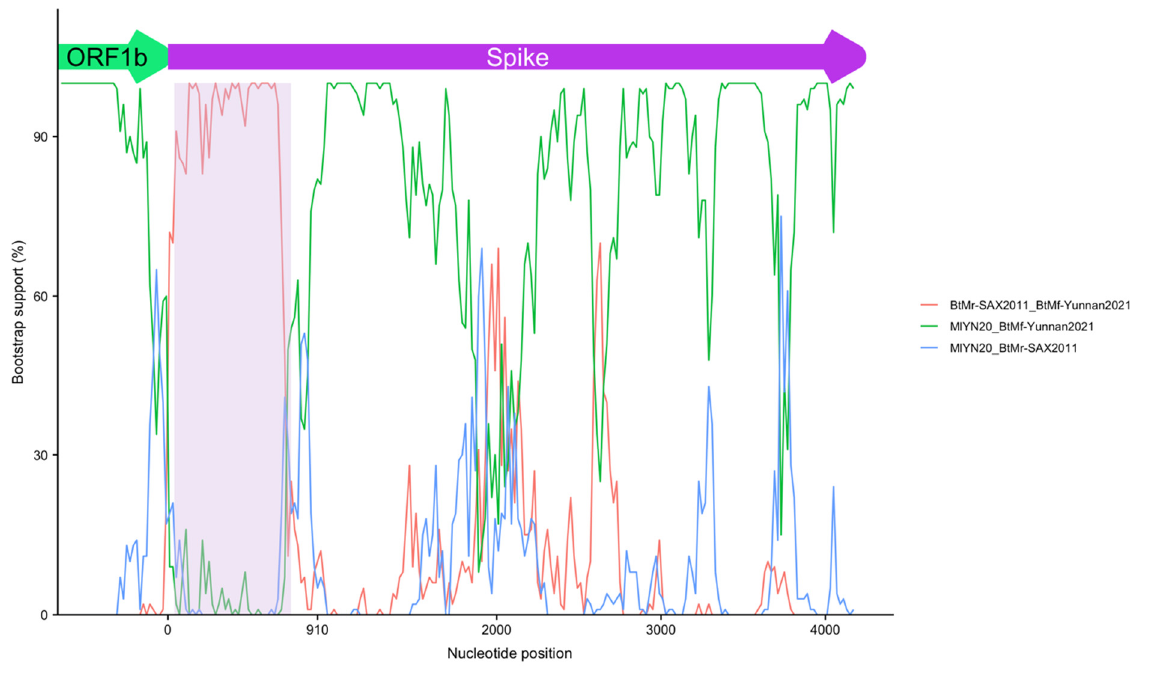
Figure 8. Spike recombination. Bootstrap support for recombination in subunit 1 of the spike protein of BtMf-Yunnan2020. The recombination involves the first 750 nucleotides of the spike (shaded area). The BtMr-SAX2011 spike was identified as the minor parent in this recombination.